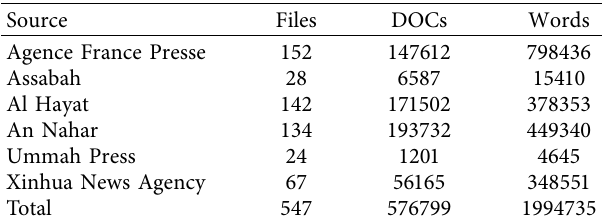
Table 5: Statistics of Arabic Gigaword Third Edition